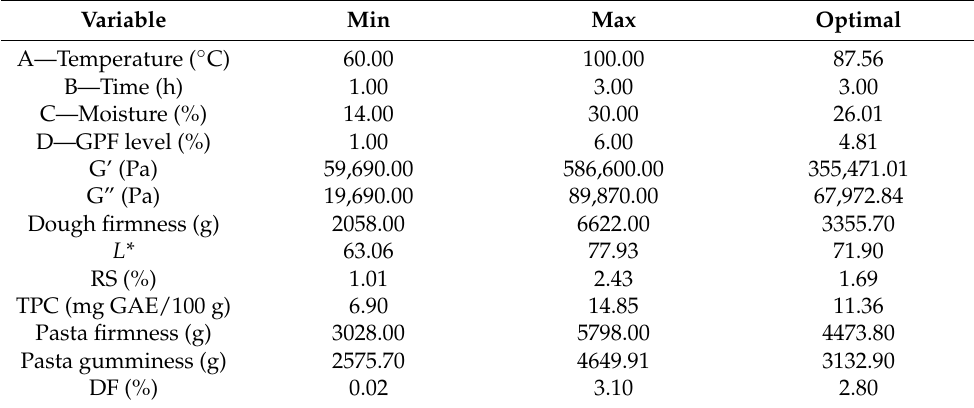
Table 5. Minimum, maximum, and optimal values of the